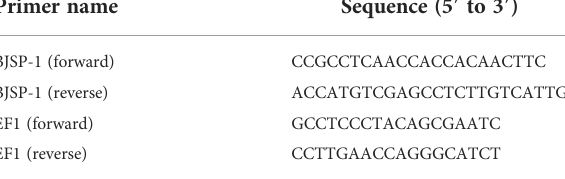
TABLE 1 qRT-PCR primers for P. xylostella BJSP-1 and